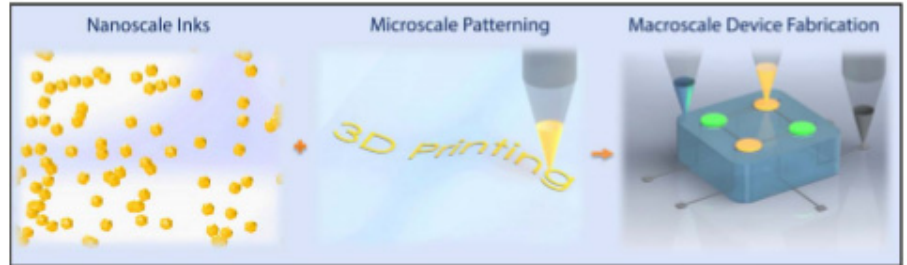
Figure 6. Multiscale 3D printing of functional devices and bioelectronics Reproduced with the permission of Reference [24]. Copyright National Science Foundation.